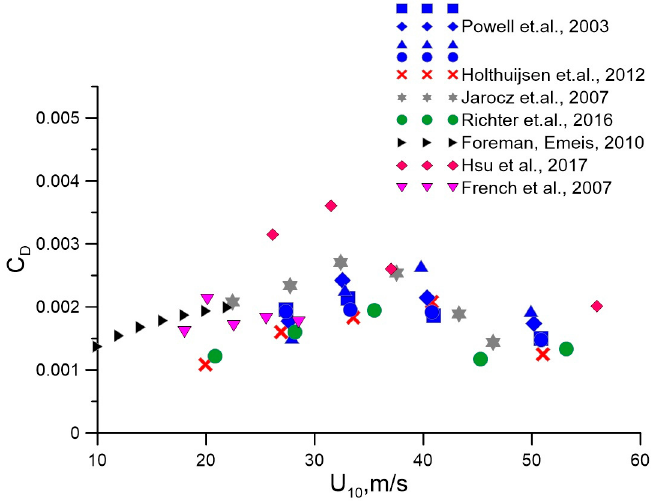
Figure 1. Dependence of the neutral aerodynamic drag coefficient on U 10 . The symbols correspond to the field measurements from [28], [31–36].